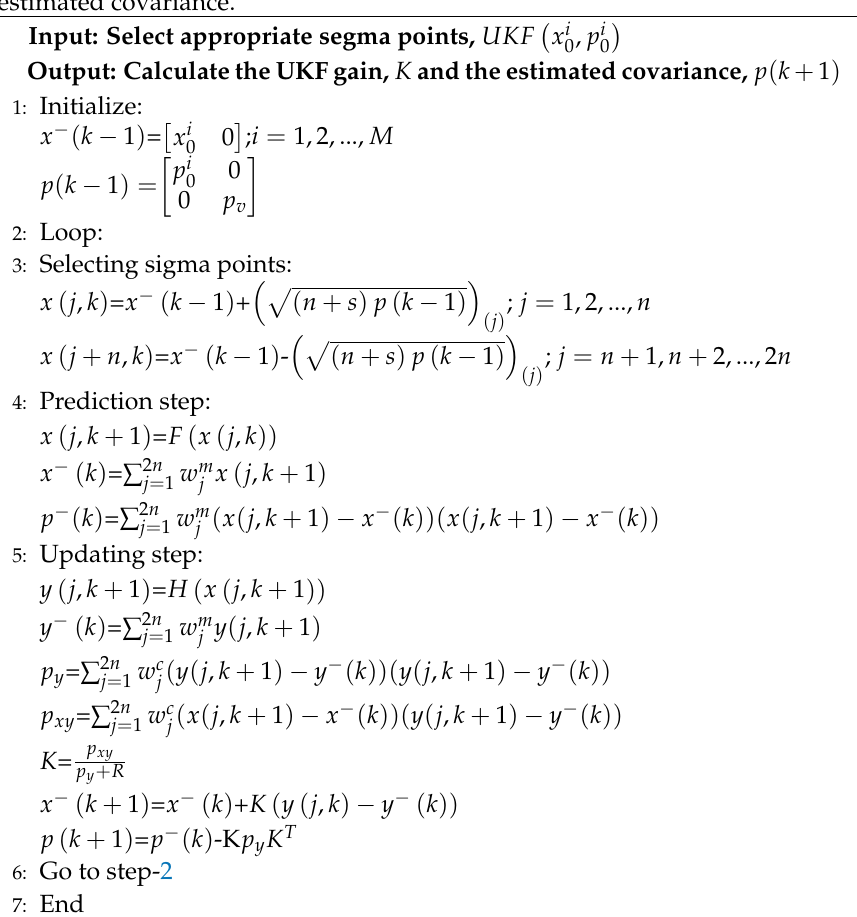
Algorithm 1 In the proposed scheme based on the UKF, all CUs are calculated the UKF gain and the estimated